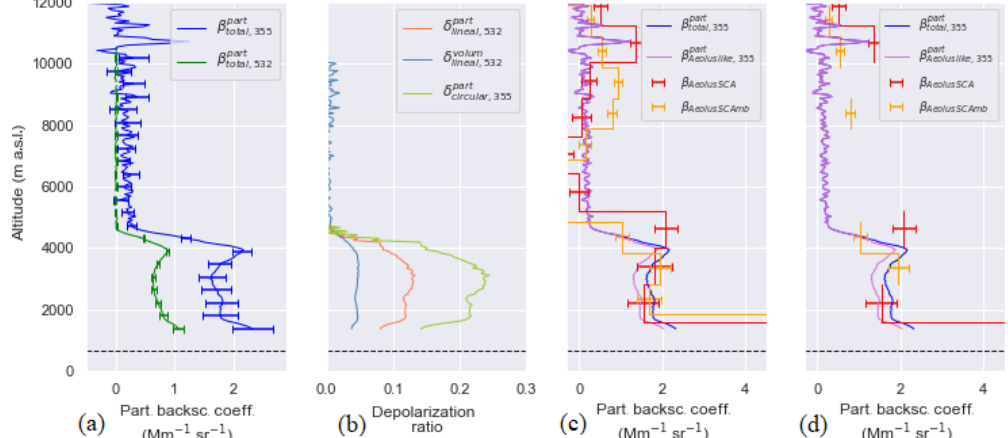
Figure 5. Vertical profiles for the case study in Granada on 5 September 2019: (a) ground-based particle backscatter coefficient profiles at 355 and 532nm with their uncertainties; (b) ground-based volume and linear particle depolarization ratios at 532nm and the derived circular particle depolarization ratio at 355nm; (c) Aeolus SCA and SCAmb co-polar particle backscatter coefficients (without quality flags) and the corresponding ground-based Aeolus-like backscatter coefficient. Panel (d) is the same as panel (c) but considering preliminary quality flags. Ground-based lidar profiles were obtained from the continuous measurement of the system from 18:00 to 18:30UTC. Satellite-based profiles correspond to the Aeolus overpass at 18:04UTC.